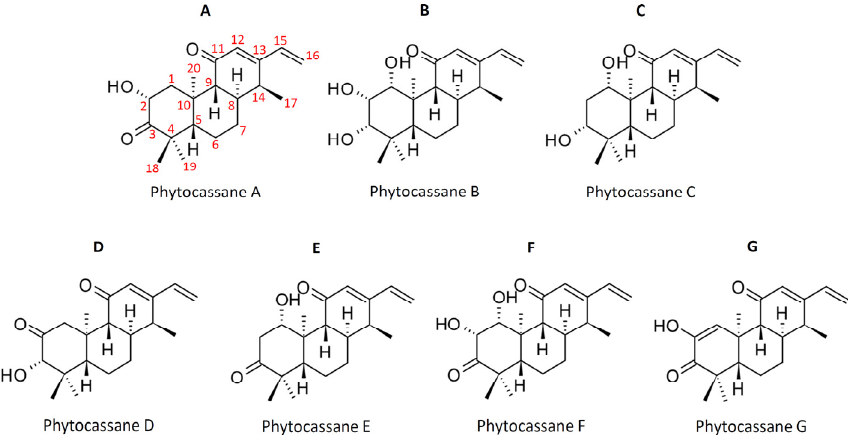
Figure 2. Phytocassanes so far isolated from rice.